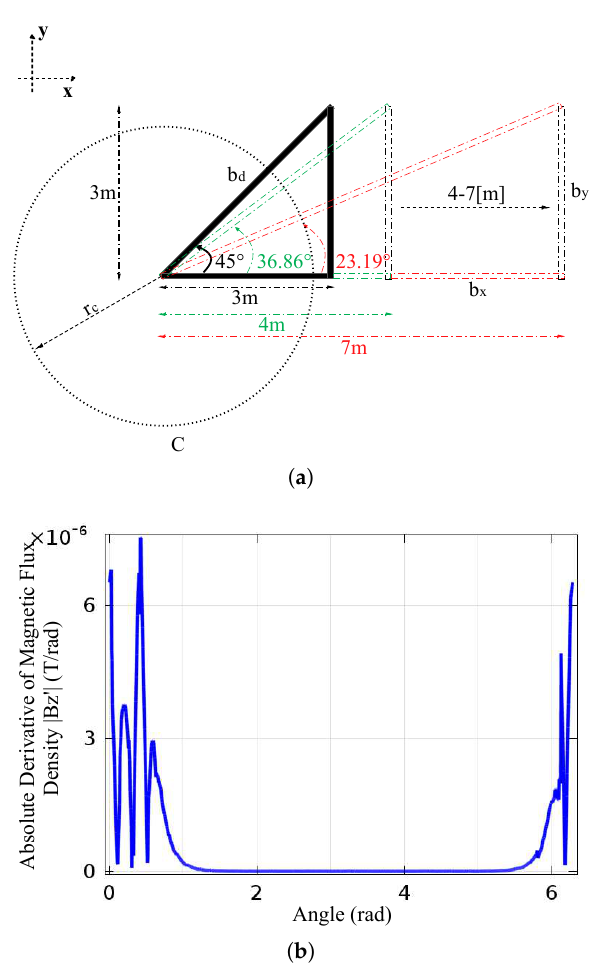
Figure 5. ( a ) Variation in mesh dimensions: Reduction in angular displacement from 45 ◦ to 23.19 ◦ between b x and b d , when length of branch b x is increased from 3 m to 7 m. First order derivative of magnetic flux density is taken on circle C of radius r c . ( b ) 1st order derivative on circle C for mesh dimensions 7 × 3 m. Peak at 0 rad corresponds to orientation of b x , peak at 0.4047 rad corresponds to orientation of b d , the third peak is a fake which appears due to overlapping of side peaks of b x and b d